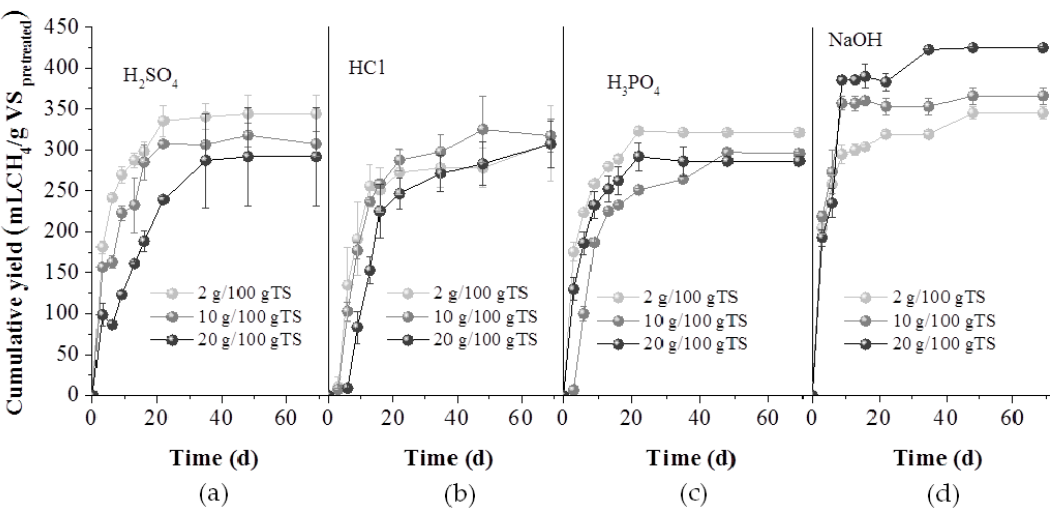
Figure 5. Cumulative methane yield of the solid fraction obtained after pretreatment of GL waste with H 2 SO 4 ( a ), HCl ( b ), H 3 PO 4 ( c ) and NaOH ( d ), at the concentrations of 2, 10 and 20 g/100 gTS, respectively.